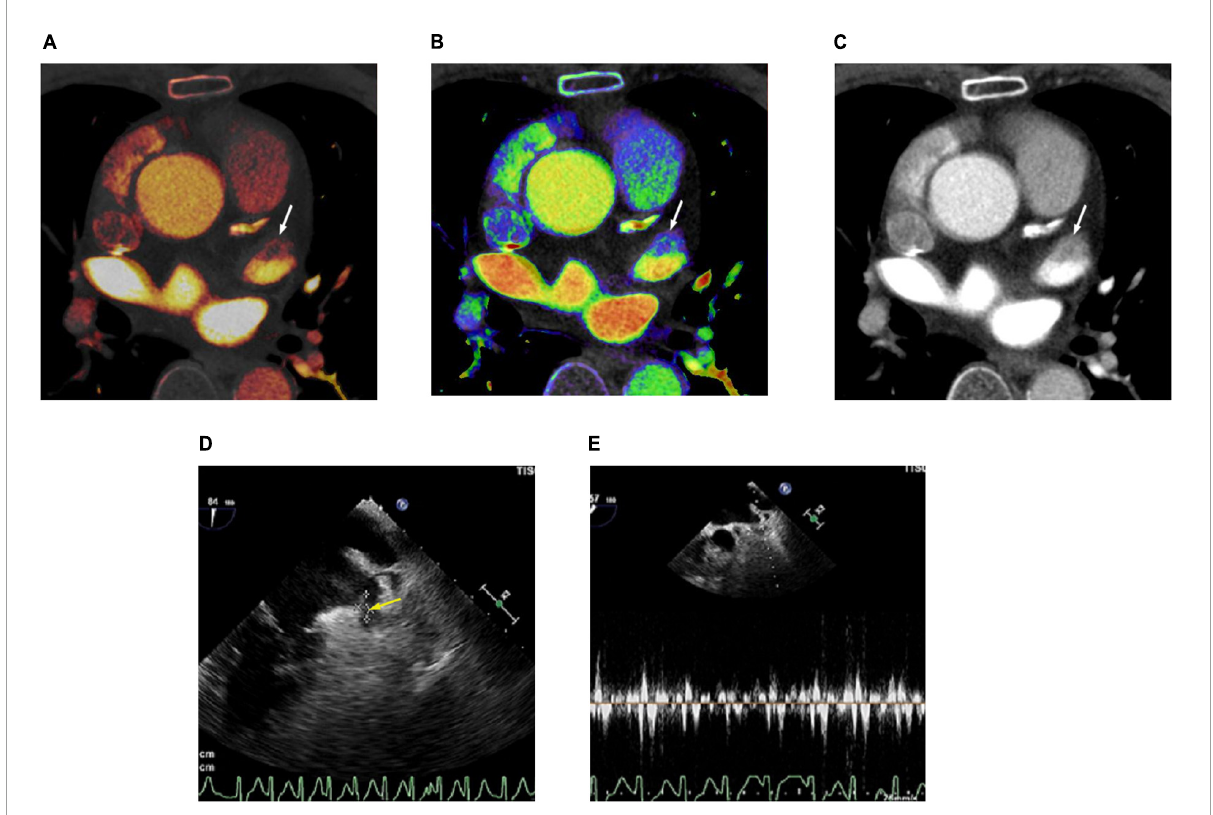
FIGURE3 Cardiac computed tomography (CT) and transesophageal echocardiography (TEE) images in 78-year-old man with left atrial appendage (LAA) thrombus and spontaneous echo contrast (SEC). (A) Dual-energy CT-derived iodine map shows filling defect in LAA (arrow), with LAA/AA iodine concentration ratio of –0.18 (true positive finding). (B) Dual-energy CT-derived Z eff image shows filling defect in LAA (arrow), with LAA/AA Z eff ratio of 0.54 (true positive finding). (C) Conventional CT image shows filling defect in the LAA (arrow) with LAA/AA HU ratio of 0.11 (true positive finding). (D) TEE image demonstrates thrombus (arrow) and SEC in LAA. (E) Doppler flow measurement of TEE shows reduced emptying velocity of 38 cm/s in LAA besides the thrombus. For quantitative assessment, LAA/AA iodine concentration ratio ≤ –0.09, LAA/AA Z eff